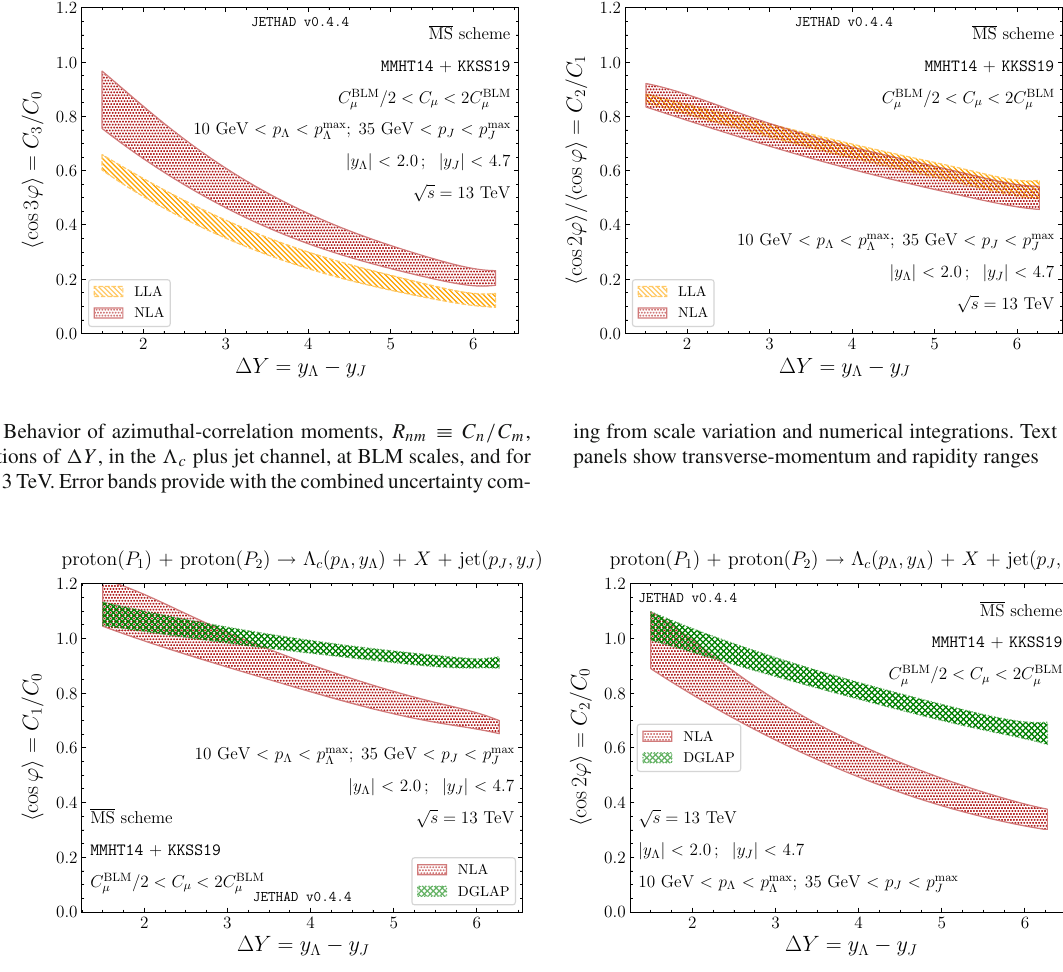
Fig. 7 BFKL-versus-DGLAP comparison for R 10 ≡ (cid:14) cos ϕ (cid:15) and R 20 ≡ (cid:14) cos2 ϕ (cid:15) azimuthal-correlation moments, as functions of (cid:5) Y , in the (cid:2) c plus jet channel, at BLM scales, and for